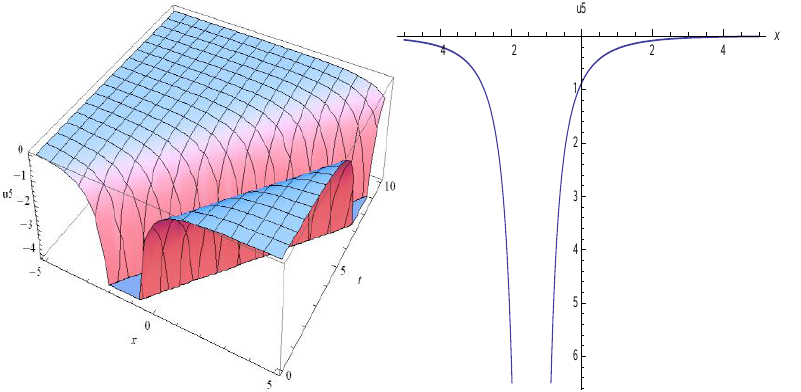
Figure 3. Dark soliton solution (36) of Equation (1) and its projection at 𝑡 = 0 when 𝜇 = 0.4,𝜆 = Figure 0.5, 𝐴 1 = 0.2,𝐴 2 = 0.1 .